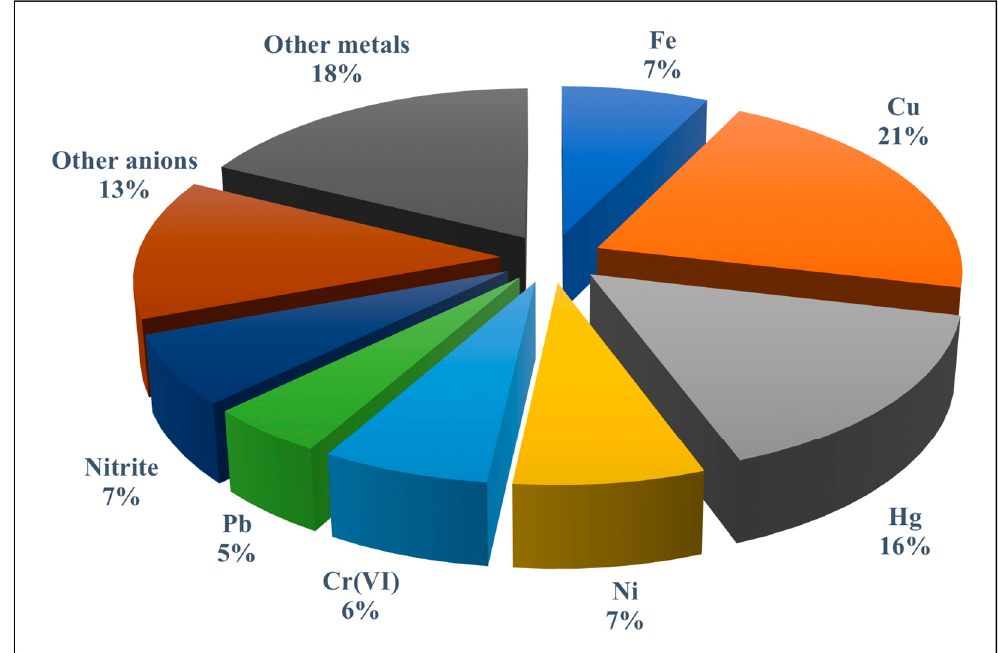
Figure 2. Percentage of publications dealing with paper-based assay devices (PADs) and microfluidic paper-based devices (microPADs) for the detection of trace metals and anions. The group of other metals includes Mn, Zn, Ag, Se, Cd, Co, Ce, Al, and As; the group of other anions includes iodate, iodide, cyanide, fluoride, sulphate, sulphite, chloride, and sulphide.